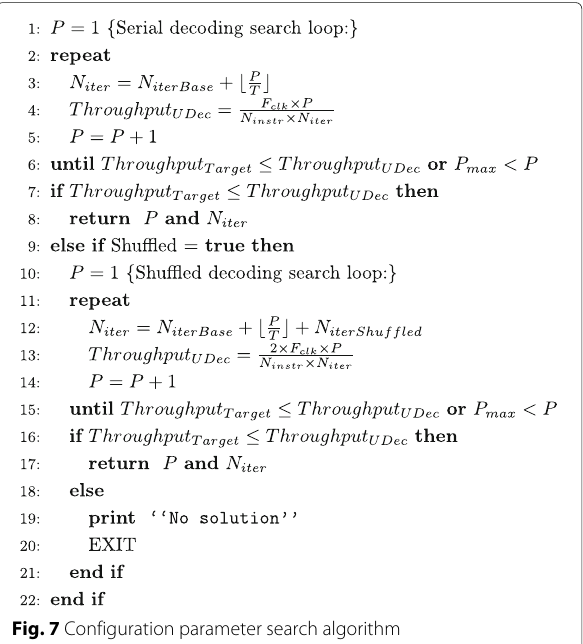
Table 2 Comparison of necessary number of decoding iterations regarding the level of sub-block parallelism for 188 bytes